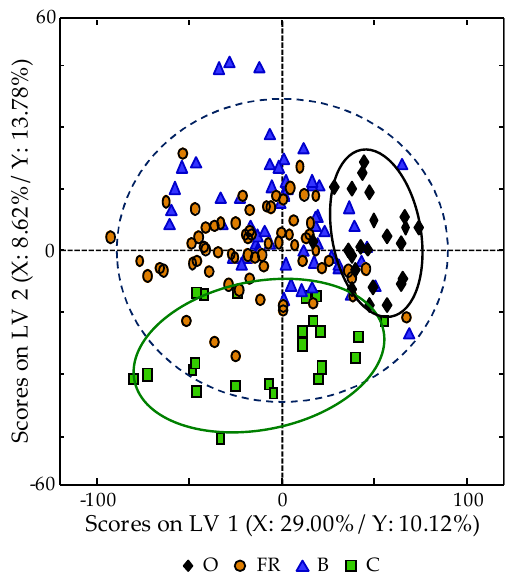
Figure 4. Partial least square-discriminant analysis (PLS-DA) scores plots of LV1 vs. LV2 when using HPLC-UV fingerprints registered at 250 nm as chemical descriptors.